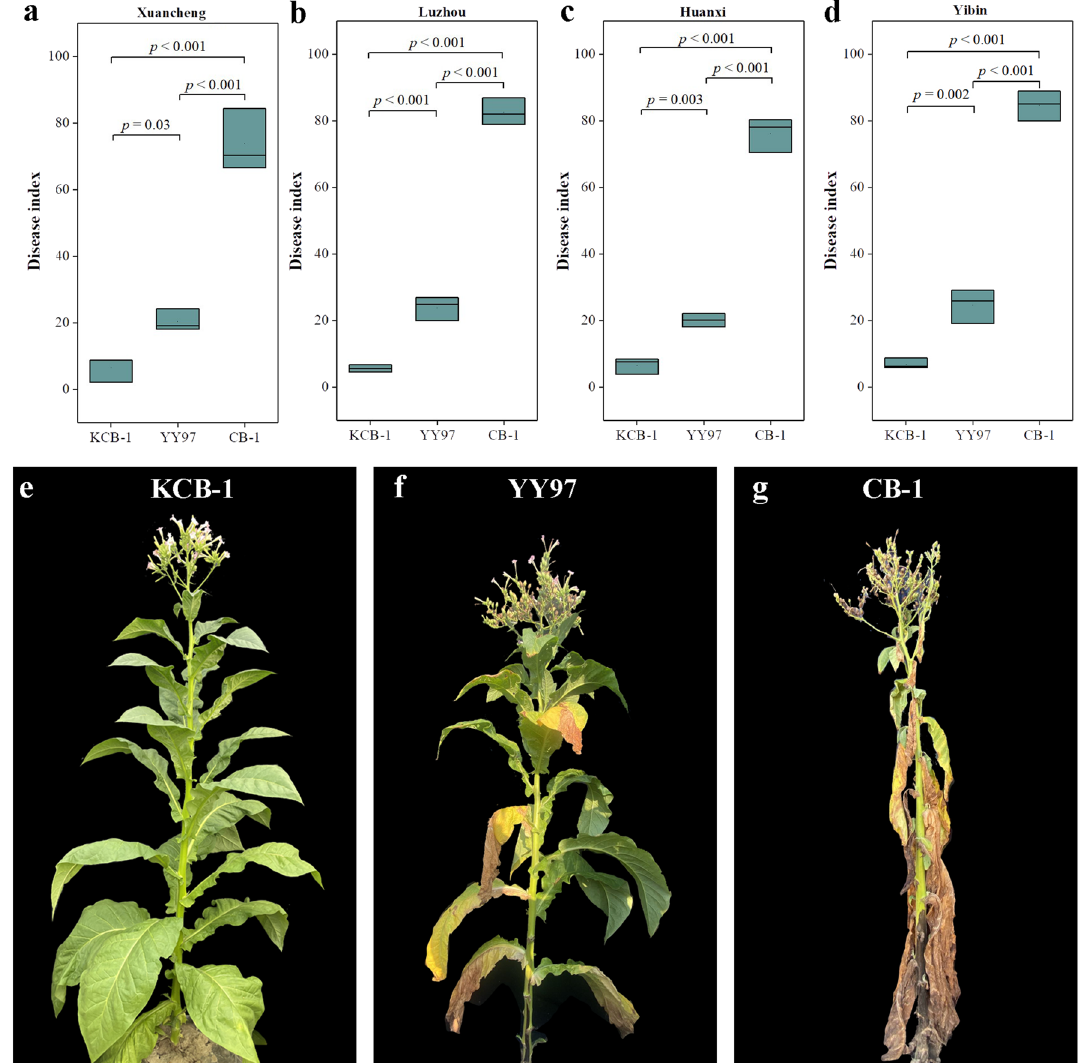
Figure 2. Disease index statistics for KCB-1, CB-1 and YY97. ( a ) Disease index statistics for KCB-1, CB-1 and YY97 in Xuancheng. ( b ) Disease index statistics for KCB-1, CB-1 and YY97 in Luzhou. ( c ) Disease index statistics for KCB-1, CB-1 and YY97 in Huanxi. ( d ) Disease index statistics for KCB-1, CB-1 and YY97 in Yibin. ( e – g ) Representative images of the KCB-1, YY97 and CB-1 from the same period. Data were analyzed using one-way